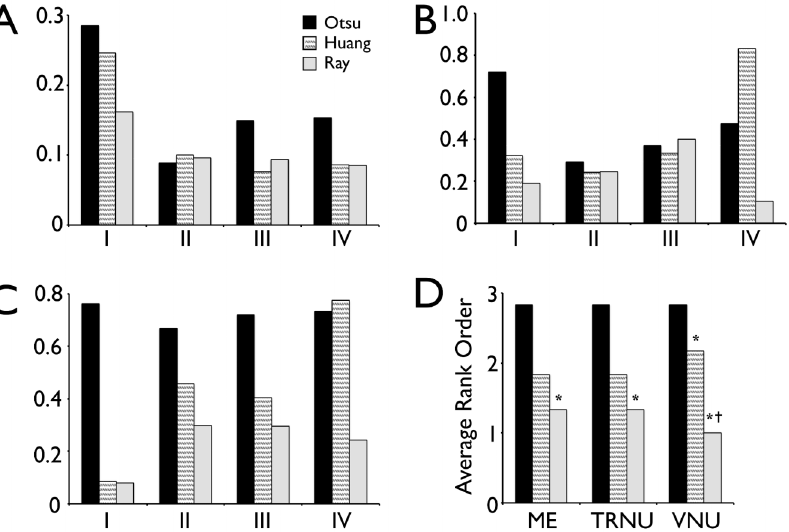
Figure 2. Quantitative comparison of thresholding methods for intravital microscopy. The various thresholding methods described (Otsu, Huang and Ray) were quantitatively compared to determine the best non-biased method(s) for each imaging type. Two independent reviewers created manual images via cell border identification for each image (I–IV in Figure 1). Images obtained with each thresholding method were then compared to the manually thresholded images, and averaged using various measures found in the literature including: A. the misclassification error, which penalizes misclassified foreground and background pixels in each image; B. total region number nonuniformity, which penalizes images based on incorrect numbers of total regions found; C. region variance nonuniformity, which compares the variance of the segmented region fluorescent intensity between manually thresholded images and the images obtained via the other thresholding methods (Otsu, Huang and Ray); D. The average rank order across six typical intravital images (see Supplemental Fig. 2 for additional images) for each measure (ME, misclassification error; TRNU, region number nonuniformity; VNU, region variance nonuniformity). * p , 0.05 relative to Otsu’s method, and { p , 0.05 relative to Huang’s method.